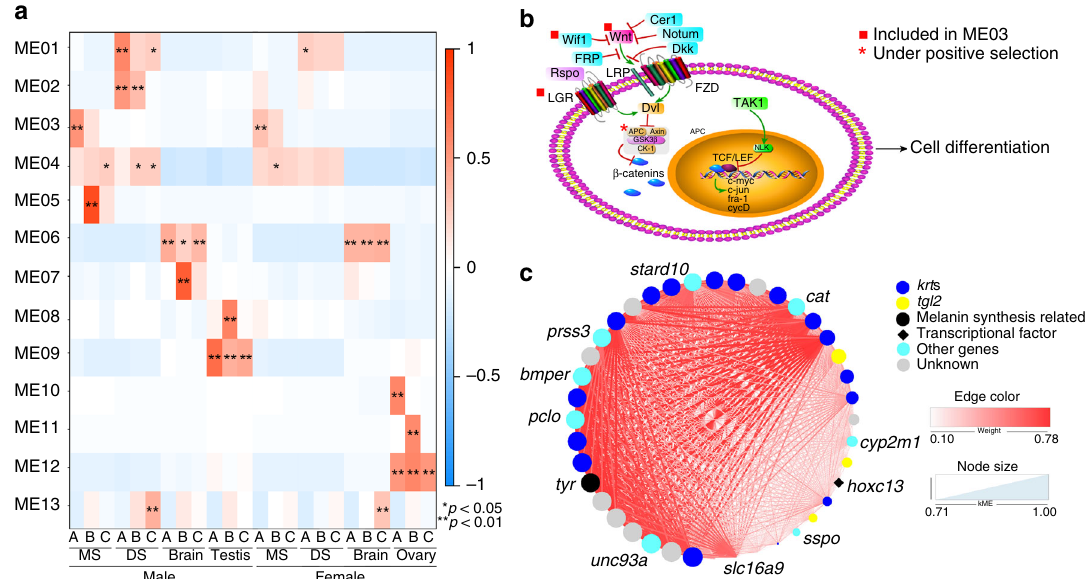
Fig. 6 Gene modules correlated with forming nuptial spines in Leptobrachium leishanense . a Correlation between coexpressed modules and sampling traits. Heatmap colors represent correlation coef fi cients (*Fisher ’ s asymptotic p < 0.05; ** p < 0.01). Rows are different modules, and columns are different sampling traits. b An illustration of the canonical Wnt pathway. Genes marked with red squares are included in the ME03 module; the gene marked with a red star is under signi fi cant positive selection in L. leishanense compared to other anurans. c Weighted coexpression network for genes in the ME05 module. Dark-blue circles are keratin genes; yellow circles are genes encoding protein-glutamine gamma-glutamyltransferase 2 ( tgl2 ); the black circle is tyr gene that is annotated as a melanin synthesis-related gene; the black diamond is a transcriptional factor ( hoxc13 ); light-blue circles are other annotated genes involved in diverse metabolic processes; gray circles are unknown genes. Colored lines represent the weight of connectivity between genes, with white to red indicating weights from low (0.10) to high (0.78). The node sizes are associated with the kME values ranging from 0.71 to 1.00. stard10 StAR-related lipid transfer (START) domain containing 10, cat catalase, tgl2 protein-glutamine gamma-glutamyltransferase 2, cyp2m1 cytochrome P450 2M1, hoxc13 homeobox protein Hox-C13, sspo SCO-spondin (precursor), slc16a9 monocarboxylate transporter 9, unc93a Protein unc-93 homolog, tyr tyrosinase, pcol protein piccolo-like, bmper BMP-binding endothelial regulator, prss3